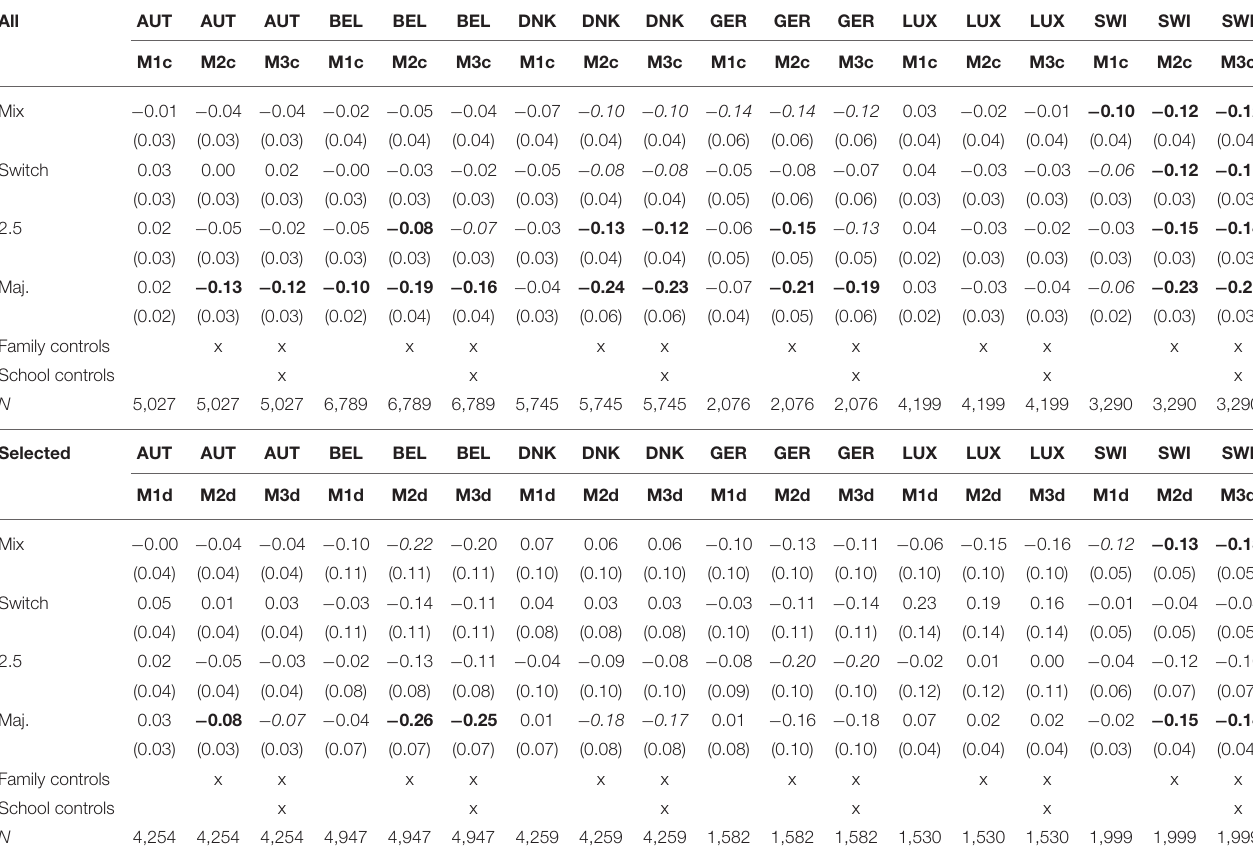
TABLE 6 | Language groups differences in educational expectations among all (upper panel) and selected group (lower panel).